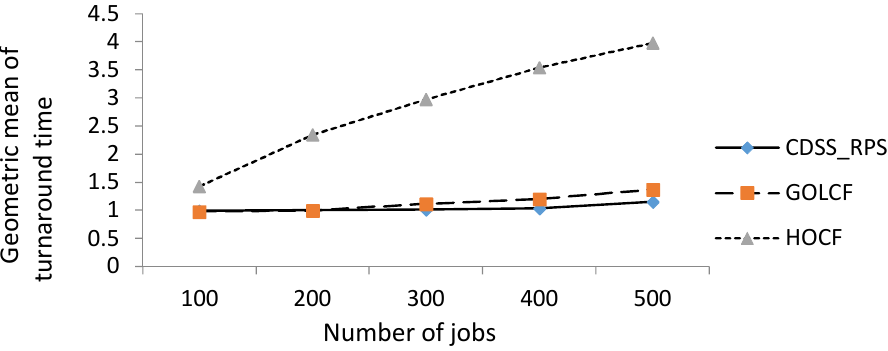
Figure 6. Geometric mean of turnaround time.